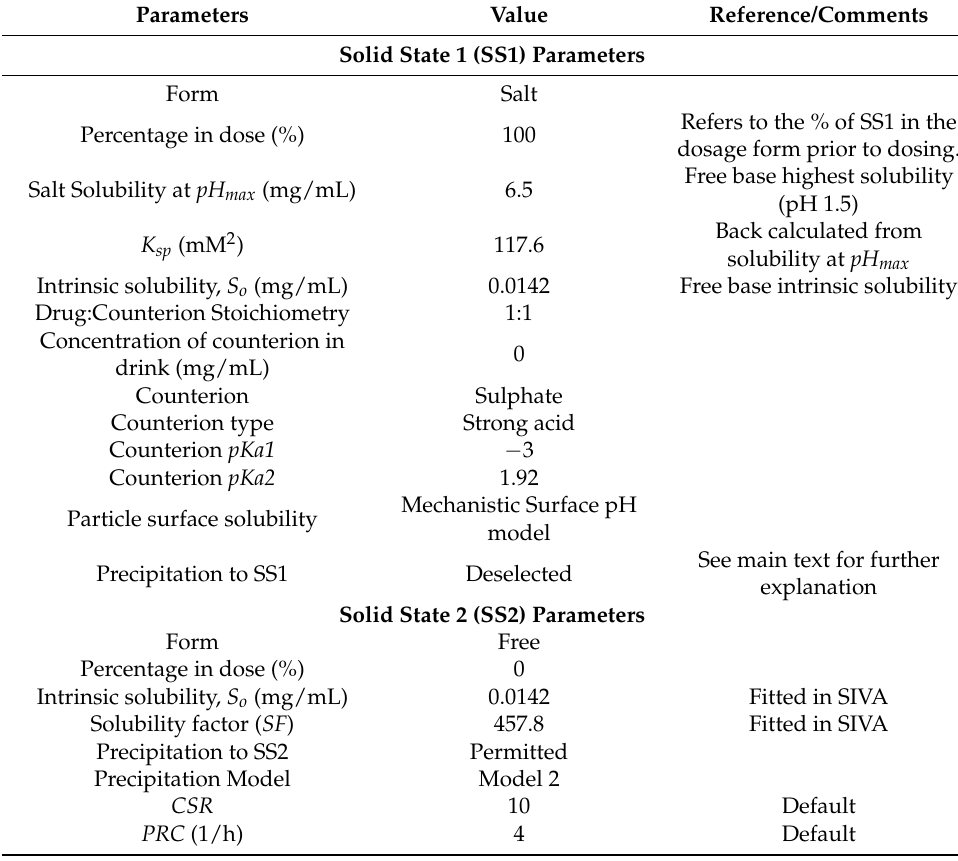
Table 3. Input parameters used in the PBPK model of the salt form of model compound. Parameters Value